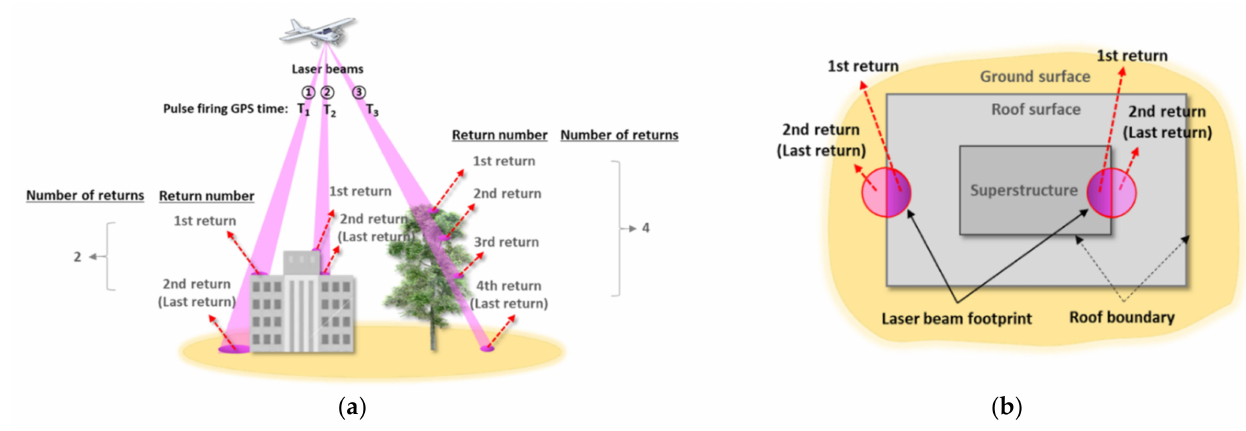
Figure 1. Multiple returns of LiDAR: ( a ) property of the multiple returns; ( b ) two returns (i.e., last return is the second return) on the building and superstructure